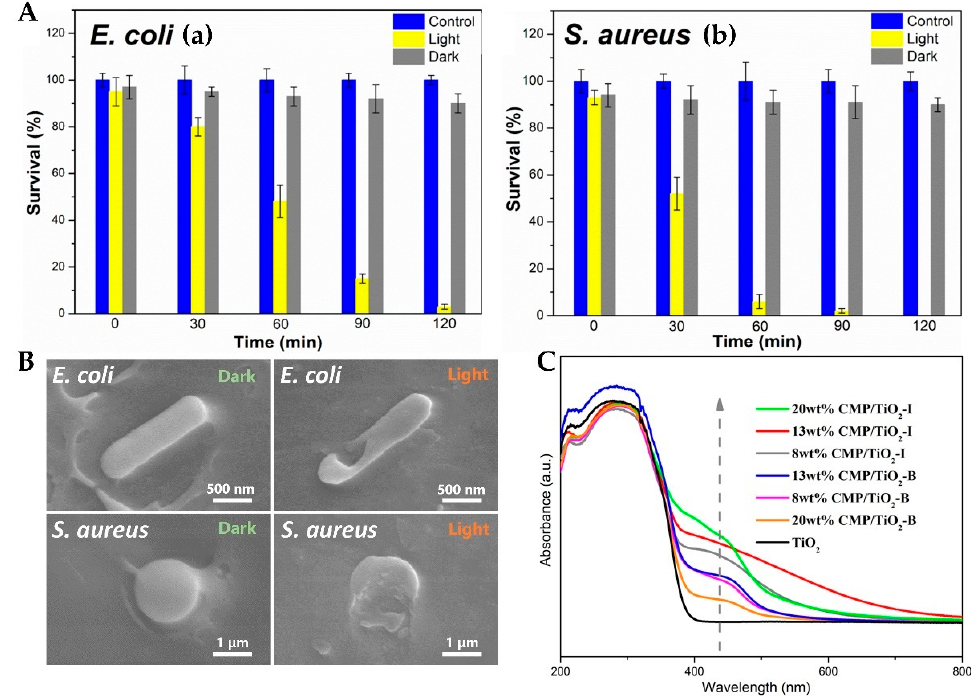
Figure 8. ( A ) Photocatalytic inactivation of E. coli ( a ) and S. aureus using 13 wt% CMP/TiO 2 -I nanocomposites. Growth images of E. coli ( b ) and S. aureus on agar plates; ( B ) SEM images of bacteria (incubated with 13 wt% CMP/TiO 2 -I nanocomposites under light irradiation and in the dark); ( C ) DRS of samples [75].